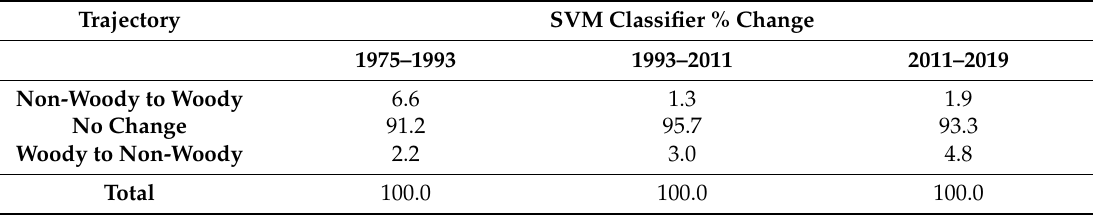
Figure 7. Change trajectory maps for successive imagery dates: ( a ) 1975 and 1993; ( b ) 1993 and 2011; ( c ) 2011 and 2019. White pixels represent no data. Table 3. Change trajectory percent changes between successive imagery dates.